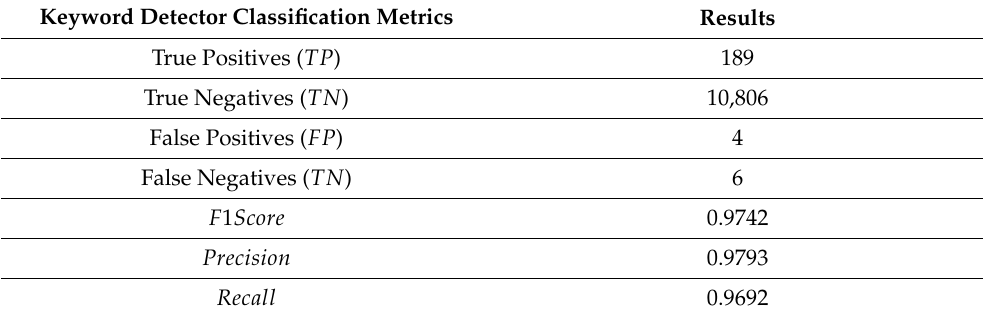
Table 1. Classification results of the target keyword ‘Marvin’ on the 11,005 test samples of the Speech Commands dataset. Standard classification metrics are used for the evaluation: Precision = TP / ( TP + FP ) , Recall = TP / ( TP + FN ) and F 1 score = 2 · ( Recall · Precision ) / ( Recall + Precision ) . Keyword Detector Classification